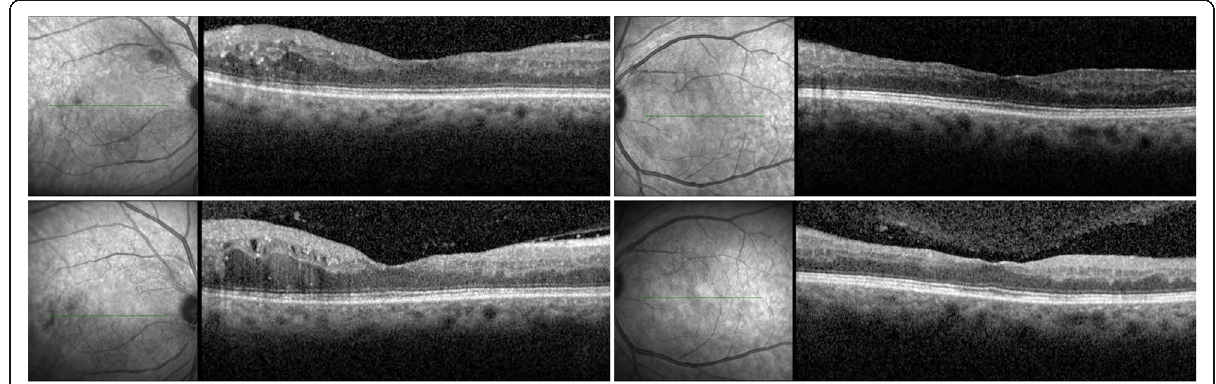
Fig. 3 SD-OCT horizontal transfoveal B-scans of the right and left eye at initial assessment ( top row ) and 3 months later ( bottom row ). Inner retinal atrophy with paracentral cystoid degeneration and edema is demonstrated in both